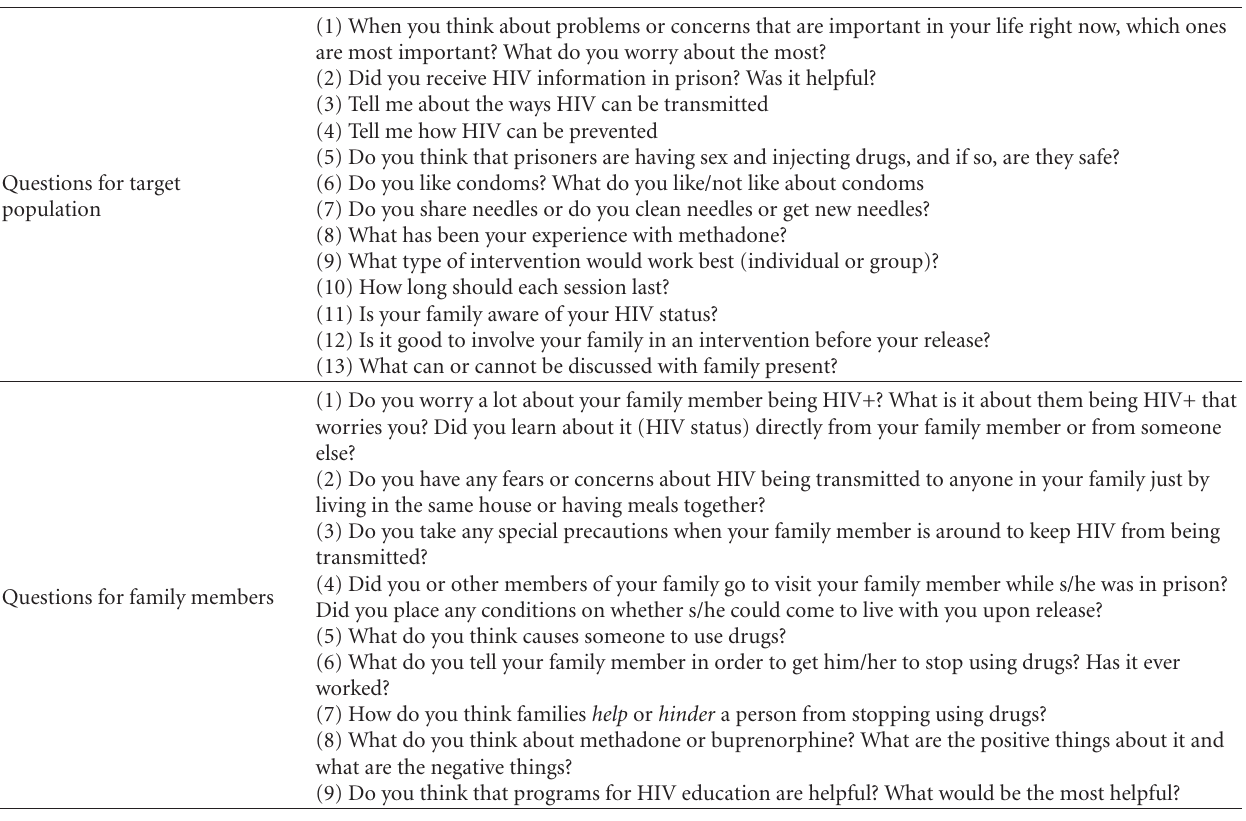
Table 1: Instrument for interviews with target population and family